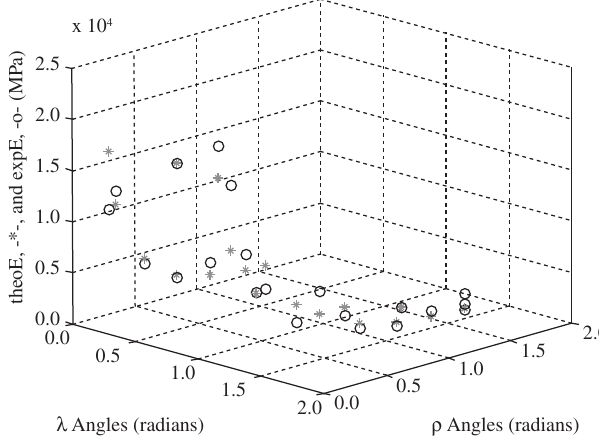
Figure 14. Theoretical (-*-) and Experimental (-o-) values of Young´s Modu- lus and Euler’s angles for Jatobá.